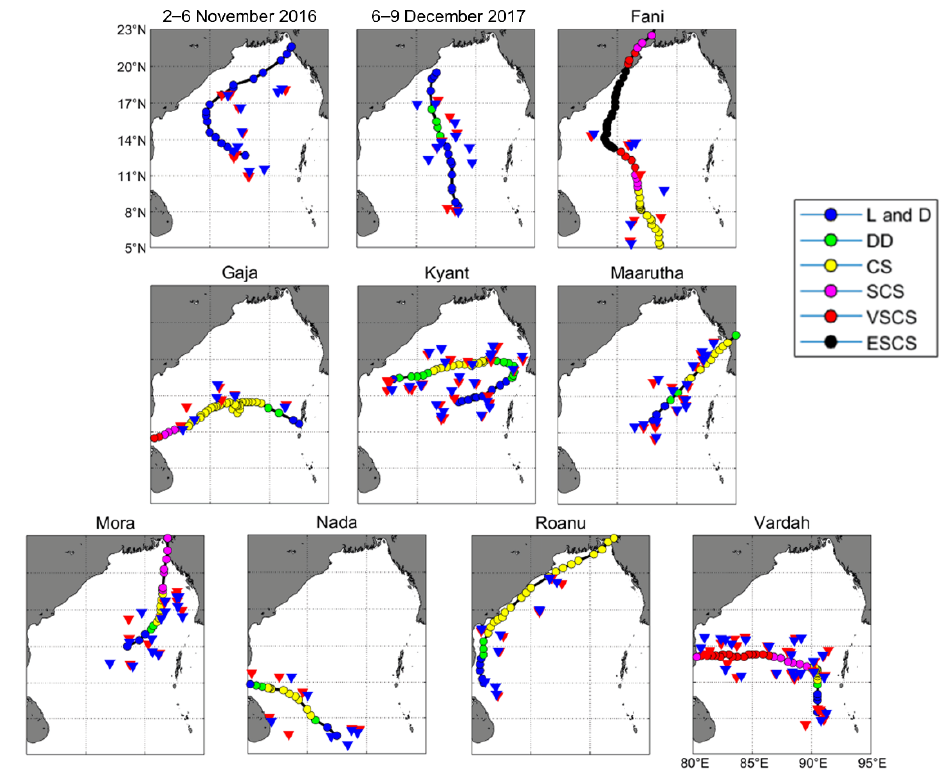
Figure 1. Tracks of 10 tropical cyclones (TCs) and positions of all selected Argo floats in Bay of Bengal (BoB) from April 2015 to December 2019. TC tracks are marked by solid red lines. (Note: blue, green, yellow, purple, red, and black dots represent low pressure (L) and depression (D), deep depression (DD), cyclonic storm (CS), severe cyclonic storm (SCS), very severe cyclonic storm (VSCS) and extremely severe cyclonic storm (ESCS), respectively, according to the India Meteorological Department. The red and blue inverted triangles represent the Argo floats before and after 10 TCs, respectively). Table 1. Basic information about 10 TCs and correlations between S SMAP , S SMOS, and S Argo before and after TC passage in BoB.